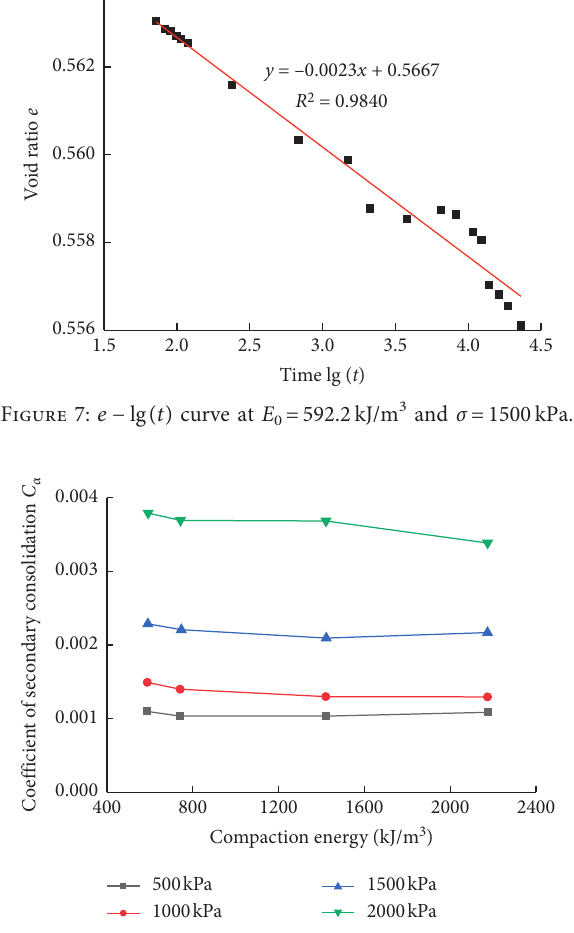
Figure 8: Coefficient of secondary consolidation with different compaction